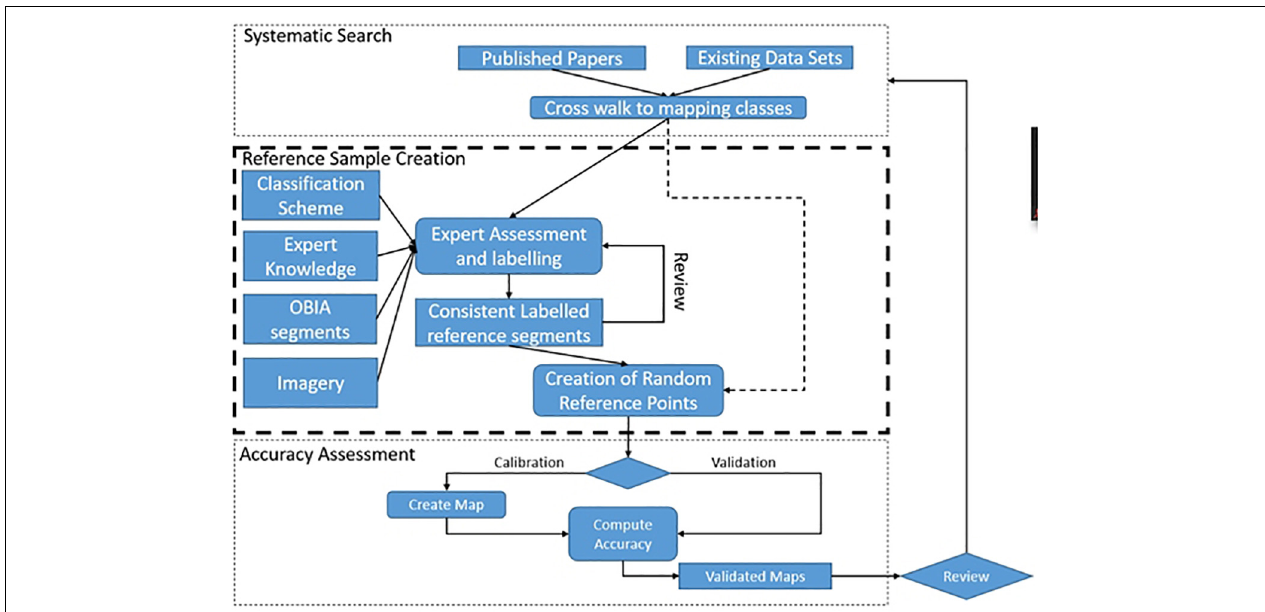
FIGURE 1 | Reference data set creation process and application to deliver global maps of coral reef geomorphic zonation and benthic cover type from satellite image